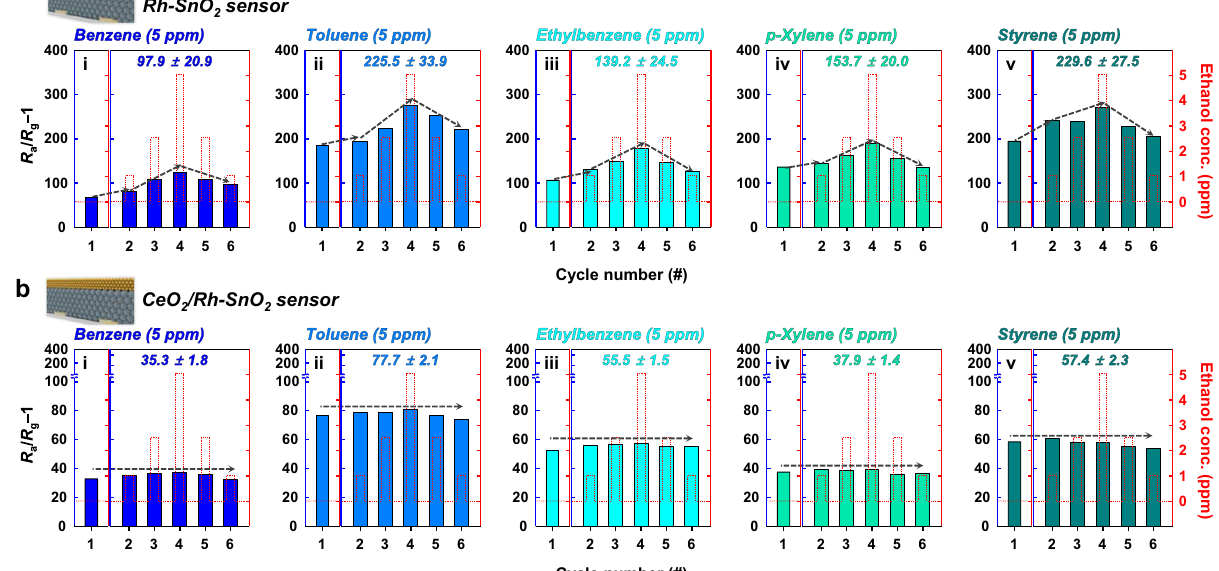
Fig.4|Multi-componentgas-sensinganalysis.a , b GasresponsesoftheRh – SnO 2 ( a )andthe0.4CeO 2 /Rh – SnO 2 ( b )sensorsto(i)gasmixtureof5ppmbenzene( fi lled bars) and 0 – 5 ppm ethanol (dashed red lines), (ii) gas mixture of 5 ppm toluene ( fi lled bars) and 0 – 5 ppm ethanol (dashed red lines), (iii) gas mixture of 5 ppm ethylbenzene( fi lledbars)and 0 – 5ppm ethanol(dashed red lines),(iv)gas mixture of 5 ppm p -xylene ( fi lledbars) and 0 – 5 ppm ethanol (dashed red lines),and (v) gas